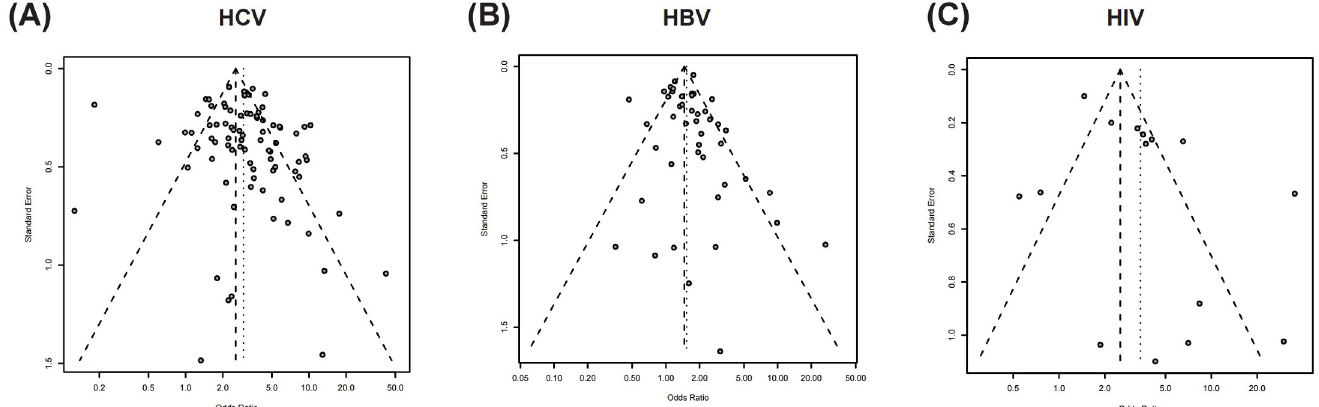
Fig 3. Funnel plots for the assessment of publication bias. Funnel plots of the meta-analyses. (A) HCV, (B) HBV, and (C) HIV. Abbreviations: HCV, hepatitis C virus; HBV, hepatitis B virus; HIV, human immunodeficiency virus. https://doi.org/10.1371/journal.pone.0262990.g003 a tattoo, with pooled ORs of 2.74 (95% CI, 2.38–3.15) [19] and 2.79 (95% CI, 2.46–3.18) [17], respectively. In addition, HIV infection has been reported to be more prevalent in tattooed subjects [22]. However, a literature search for syphilis in tattooed subjects is lacking.